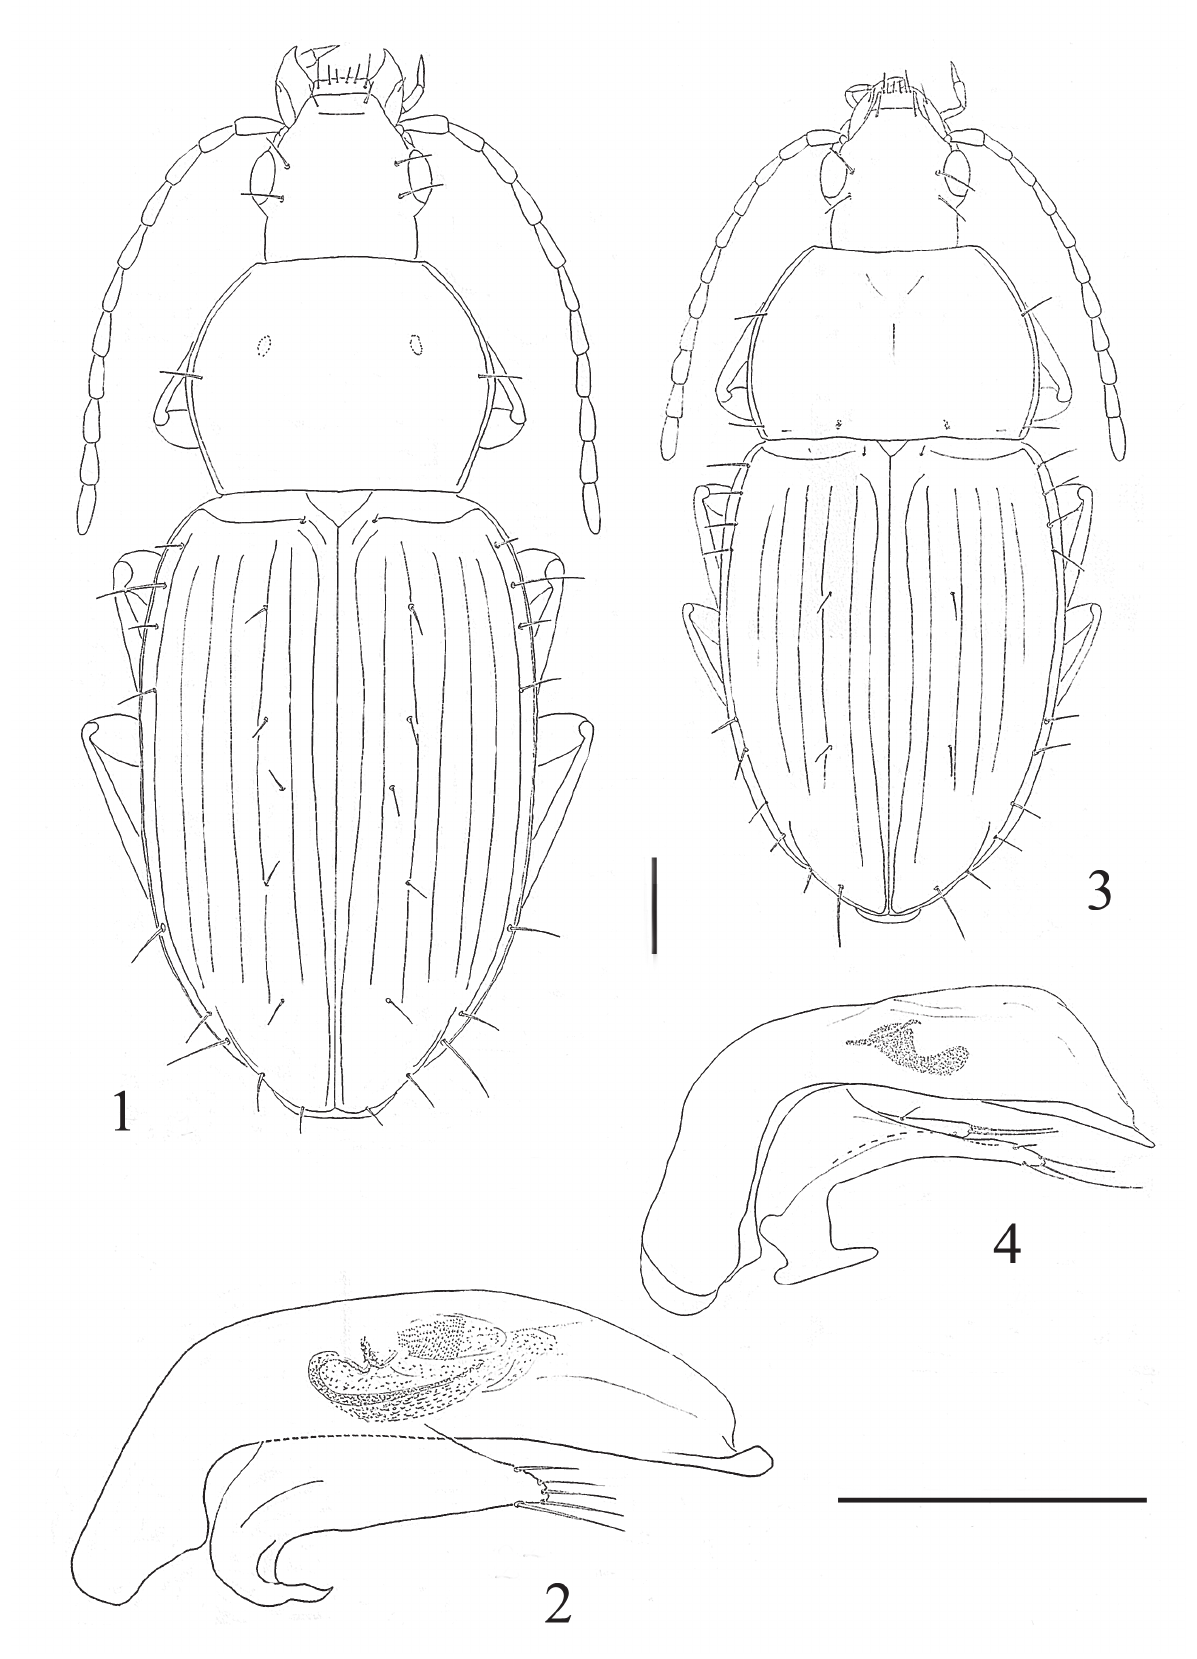
Figs 1-4. Percodermus niger Sloane: 1) habitus of ♂ from Lake St. Clair; 2) aedeagus in lateral view of LT from Great Lake. Sloa- neana tasmaniae (Sloane): 3) habitus of ♂ from Lake St. Clair; 4) aedeagus in lateral view of ♂ from Lake Osborne. Scale: 0.5